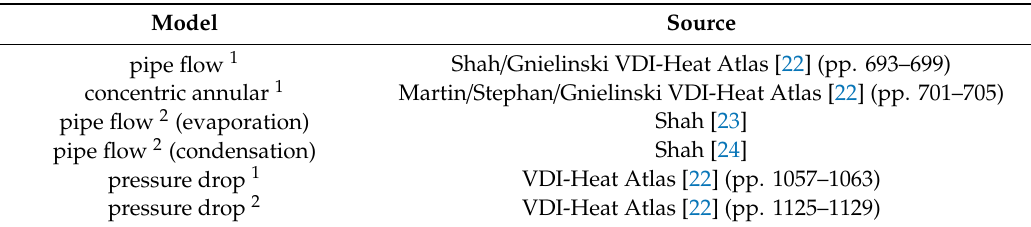
Table 2. Implemented correlations for heat transfer and pressure